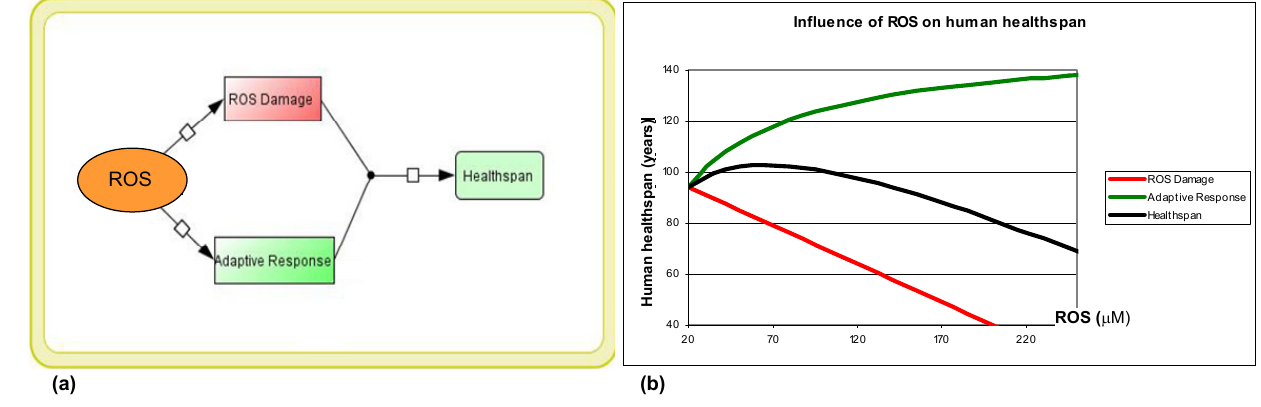
Figure 3. ROS hormesis was modeled by an integration of ROS-induced damage and ROS-induced adaptive responses with different kinetic parameters. ( a ) Model construction employing the software CellDesigner (www.celldesigner.org); ( b ) Simulation results of the model. Red curve: ROS-induced macromolecular damage is negatively and linearly correlated with healthspan. Green curve: ROS-induced adaptive responses are positively correlated with healthspan, bearing a threshold-saturation kinetic (modeled here with Michaelis-Menten kinetics). Black curve: the addition of red and green curve values gave the biphasic hormetic dose-curve with an optimal ROS dose at around 70 µM, which is correlated with maximized human